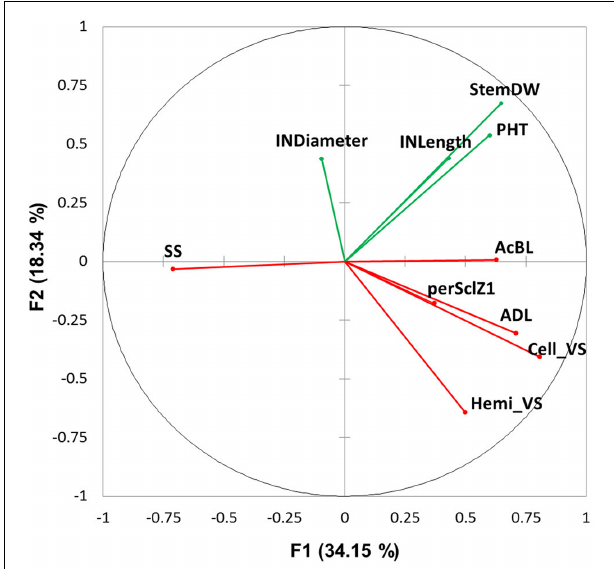
FIGURE 7 | Principal component analysis using average variables measured in well-watered and water deficit treatments at plant (PHT: plant height; StemDW: stem dry weight) and internode level (INLength: internode length; INDiameter: internode diameter; ADL: Acid Detergent Lignin in %DW, Cell_VS: cellulose content in %DW, perSclZ1: percentage of sclerenchyma tissue (red stained) in % of Z1 area, SS: soluble sugars in mg.g - 1 DW and AcBL: lignin content by acetyl bromide method in mg.g - 1 DW) at final harvest (considering internode of rank 4 below the flag leaf). Morphological variables are in green and anatomical and biochemical variables in red. The axes F1 and F2 explained 52.50% of the total variation.